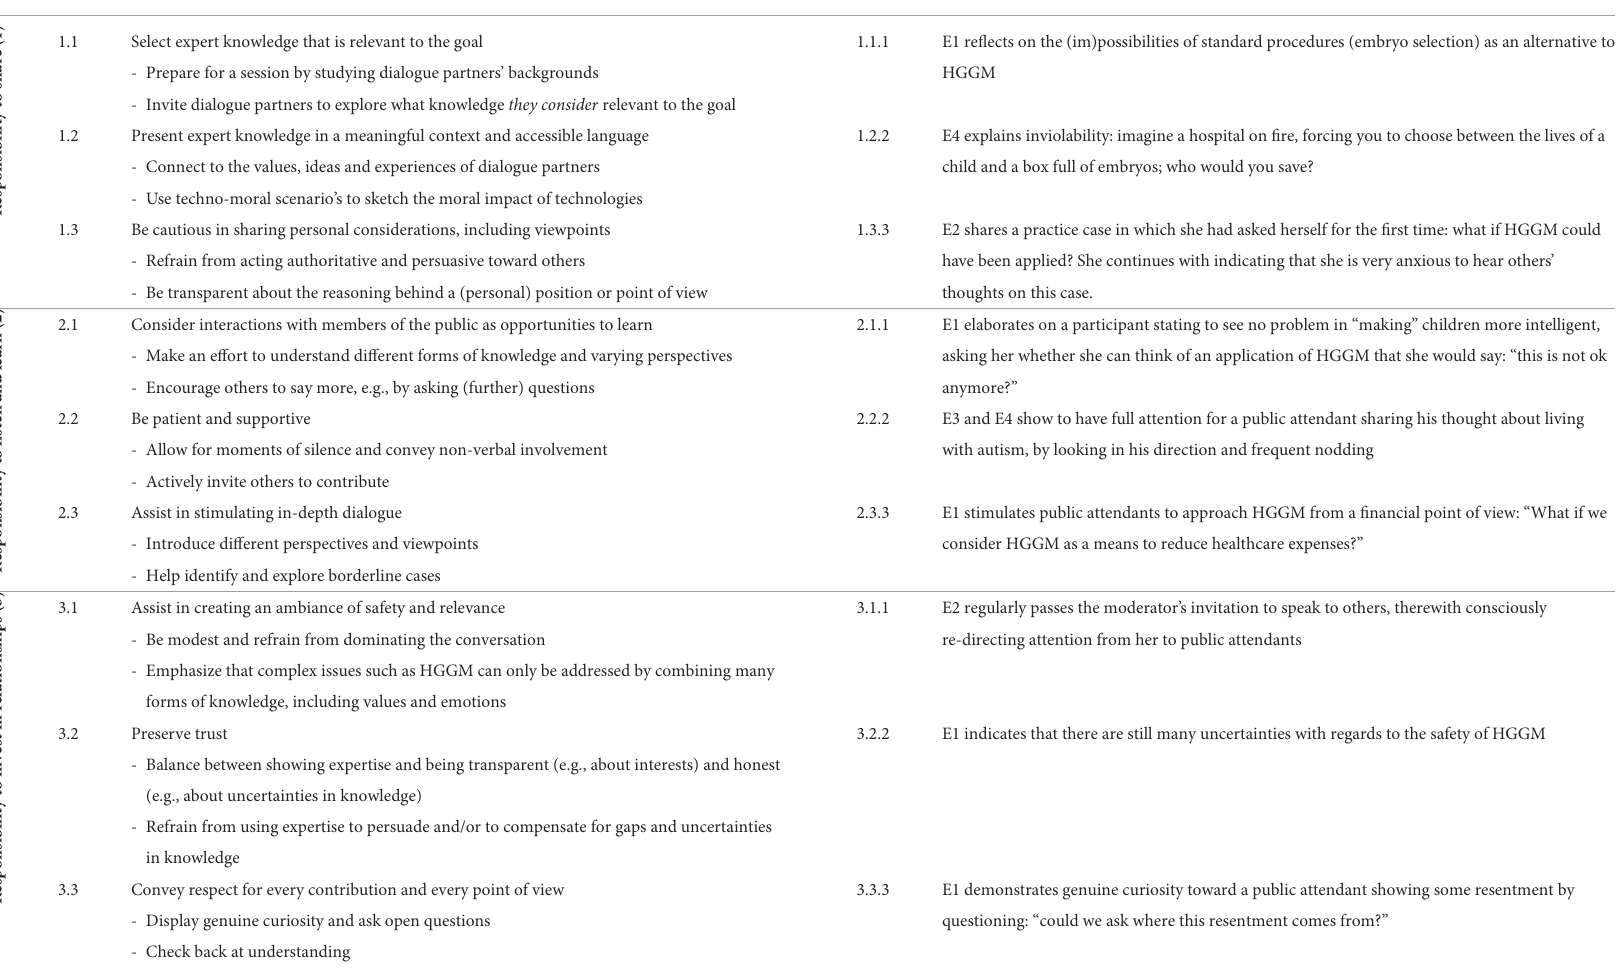
TABLE 2 Behavioral prompts and examples of concrete behavior per